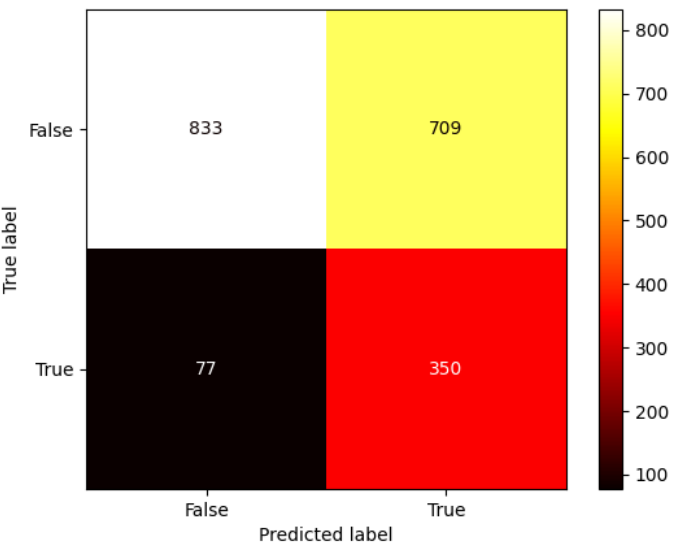
Figure 4. Pictorial representation of the confusion matrix subjected to Ethereum Fraudulence Prediction with detailed annotations. The Standalone ChaosNet suspected 350 transactions to be fraudulent which were in fact fraudulent. The algorithm declared 833 transactions to be genuine which were in fact genuine.